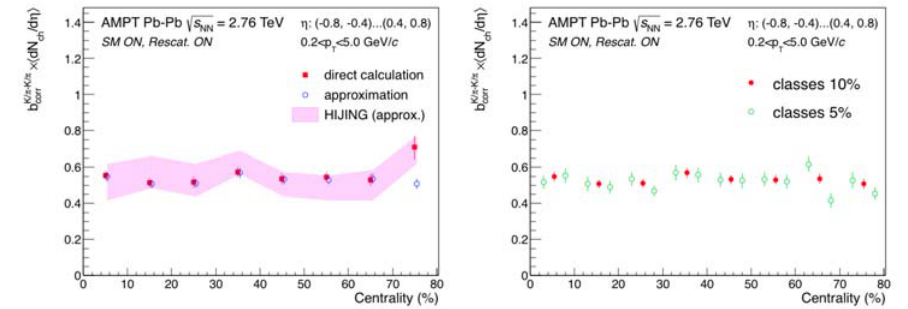
Figure 1. Scaled strength of forward-backward correlations between n K / n π ratios as a function of centrality √ = 2 . 76 TeV. Forward-backward η -intervals are ( − 0 . 8 , − 0 . 4) and (0 . 4 , 0 . 8), p in Pb–Pb collisions at s NN range of particles is 0.2–5.0 GeV / c . Left: direct calculations in AMPT (full squares) in comparison with the approximation (open circles). Results from HIJING are shown as a filled band. Right: correlation strength in centrality classes of widths 10% and 5% (classes are determined using charge particle multiplicities at forward η -ranges corresponding to the V0 detector of ALICE)